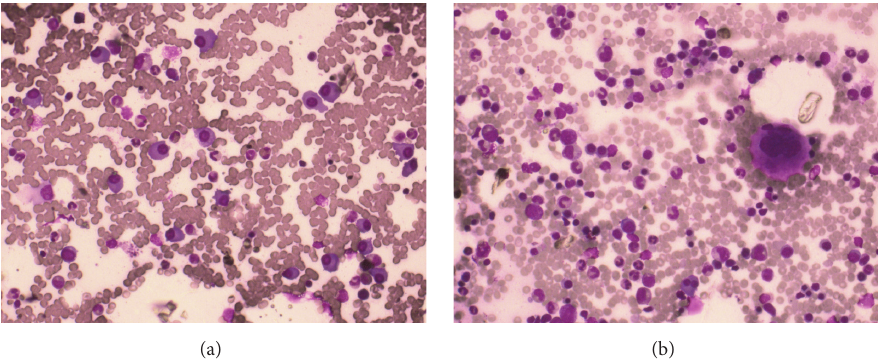
Figure 1: (a) May-Grunwald-Giemsa stain of bone marrow aspirate at diagnosis showing infiltrate of atypical plasma cells and (b) May- Grunwald-Giemsa stain after ASCT at VGPR showing reduction of the